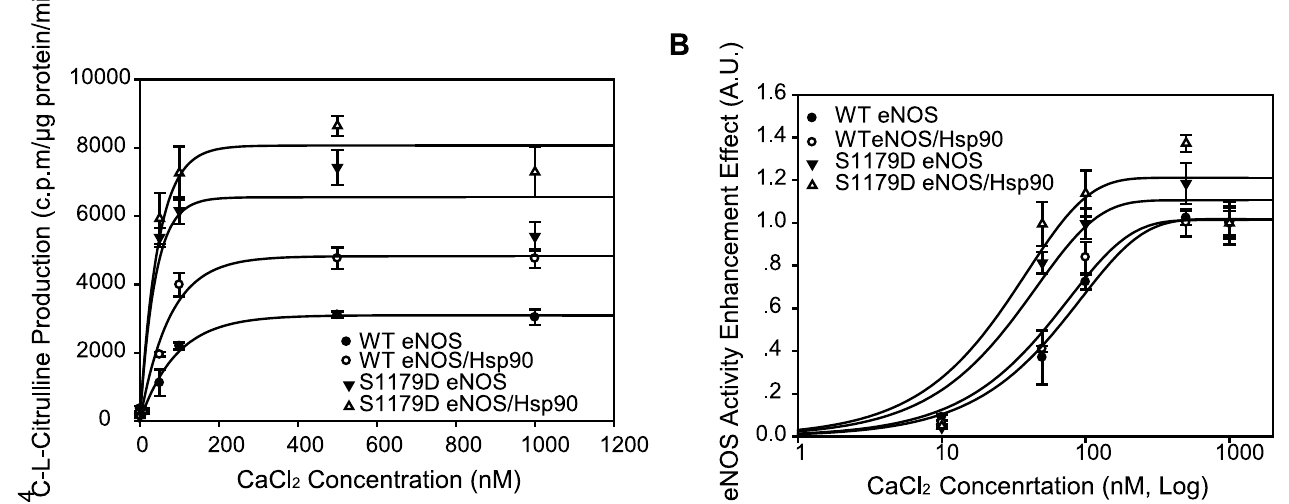
Fig 5. Hsp90 did not enhance either WT eNOS or S1179D eNOS affinity to calcium. (A) Hsp90 augmented both WT eNOS and S1179D eNOS activity capacity in the presenceof calcium. The effect of Hsp 90 on enzymatic activity of WT eNOS and S1179DeNOS was assayed by monitoringthe conversionrate of L-14C-arginine to L-14C-citrullinein the presenceof indicatedconcentration of calcium chloride(n = 5). (B) Calcium chloride-eNOS activity dynamic assay showedthat Hsp90 did not changeeither WTeNOS or mutant S1179Dsensitivity to calcium ((EC50, P > 0.05;n = 5). On the other hand, mutation S1179D significantly enhancedeNOS affinity to calcium comparing to their WT eNOS control in the absenceor presenceof Hsp90 (EC50, P < 0.05;n = 5).